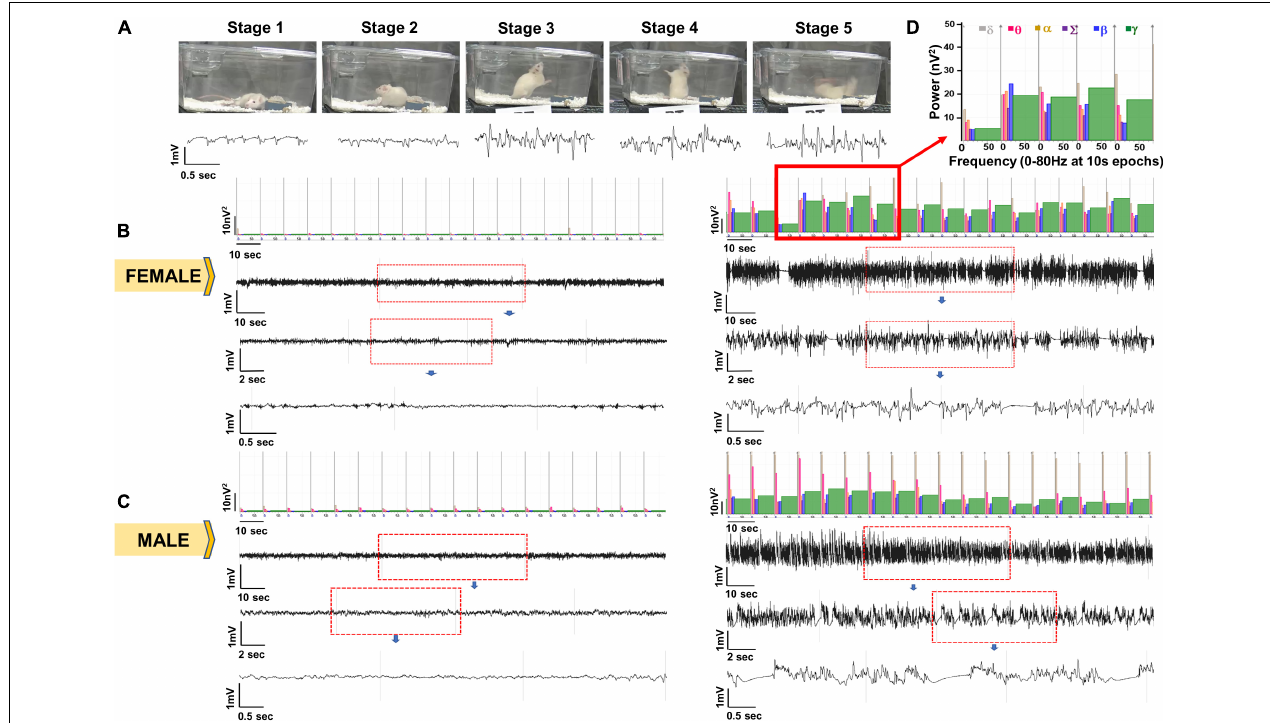
FIGURE 3 | Representative EEG traces and the corresponding images captured from integrated video-EEG system. (A) EEG signatures for seizure stages 1–5 with corresponding power and behavior. (B) Baseline (left) and SE EEG traces for a female animal. (C) Baseline (left) and SE EEG traces for a male animal. (D) Enlarged power